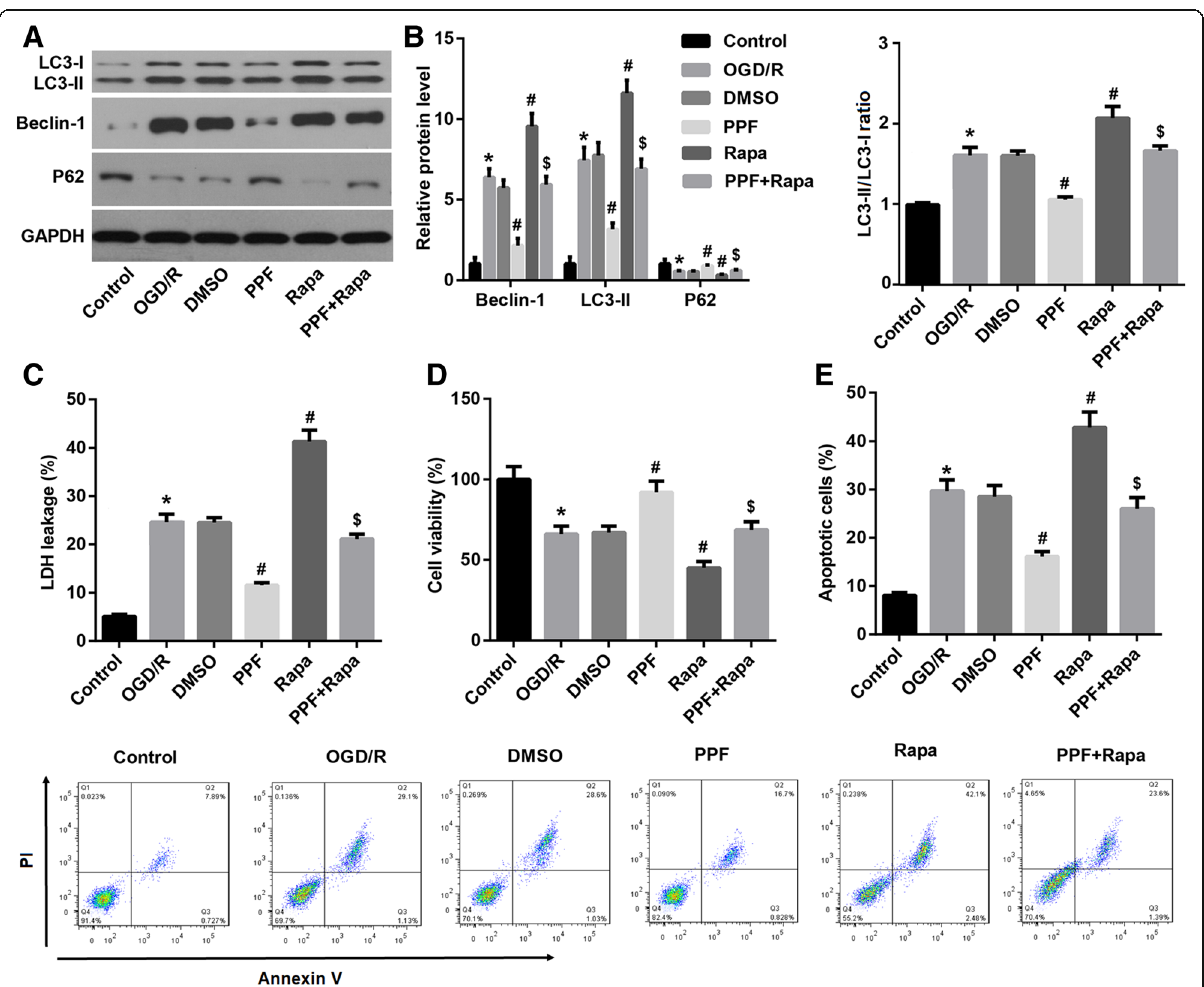
Fig. 3 Autophagy induction abolished the PPF-mediated amelioration of OGD/R-triggered cell injury. OGD/R-exposed neurons were pre-treated with the autophagy activator rapamycin (Rapa, 30 μ M), followed by propofol (PPF, 30 μ M in 0.1% DMSO) treatment. a , b Western blot was performed to evaluate the effects of autophagy activator rapamycin on protein expression of autophagy-related genes LC3, Beclin1, and p62. Quantification of western blots was shown. c LDH release, d CCK-8 cell viability, and e cell apoptosis assay were performed to evaluate whether autophagy was involved in the PPF-mediated amelioration of OGD/R-triggered cell injury. Values are represented as the mean ± SD from three independent experiments. * p < 0.05 vs. Control group; # p < 0.05 vs. DMSO group; $ p < 0.05 vs. PPF